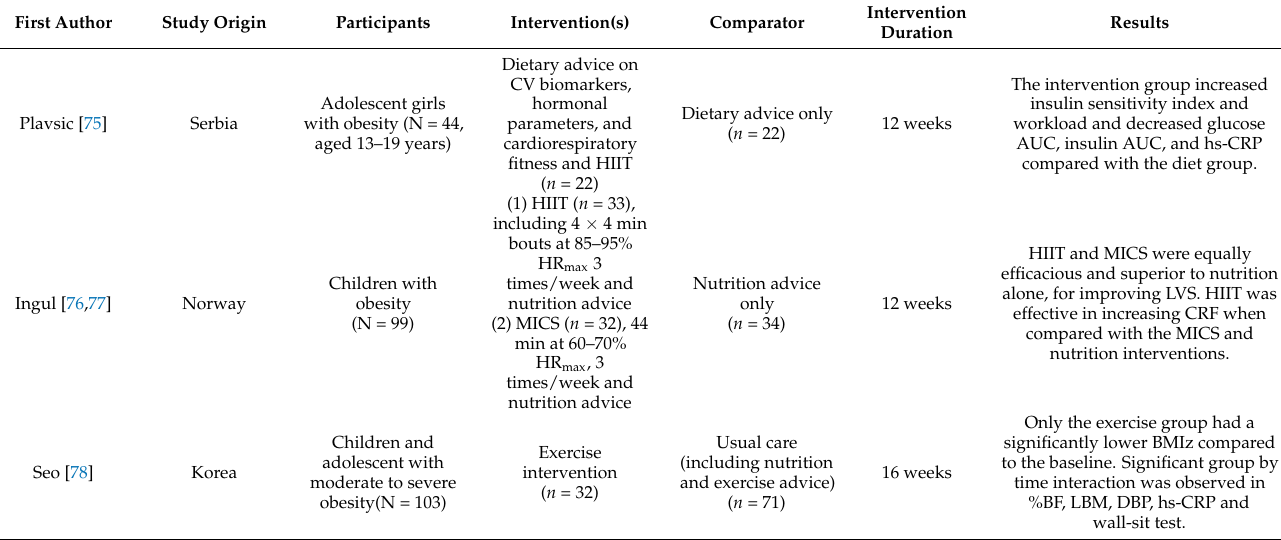
Table 5. Existing parallel RCTs assessing exercise and nutrition interventions for improving CRF among children and adolescents with